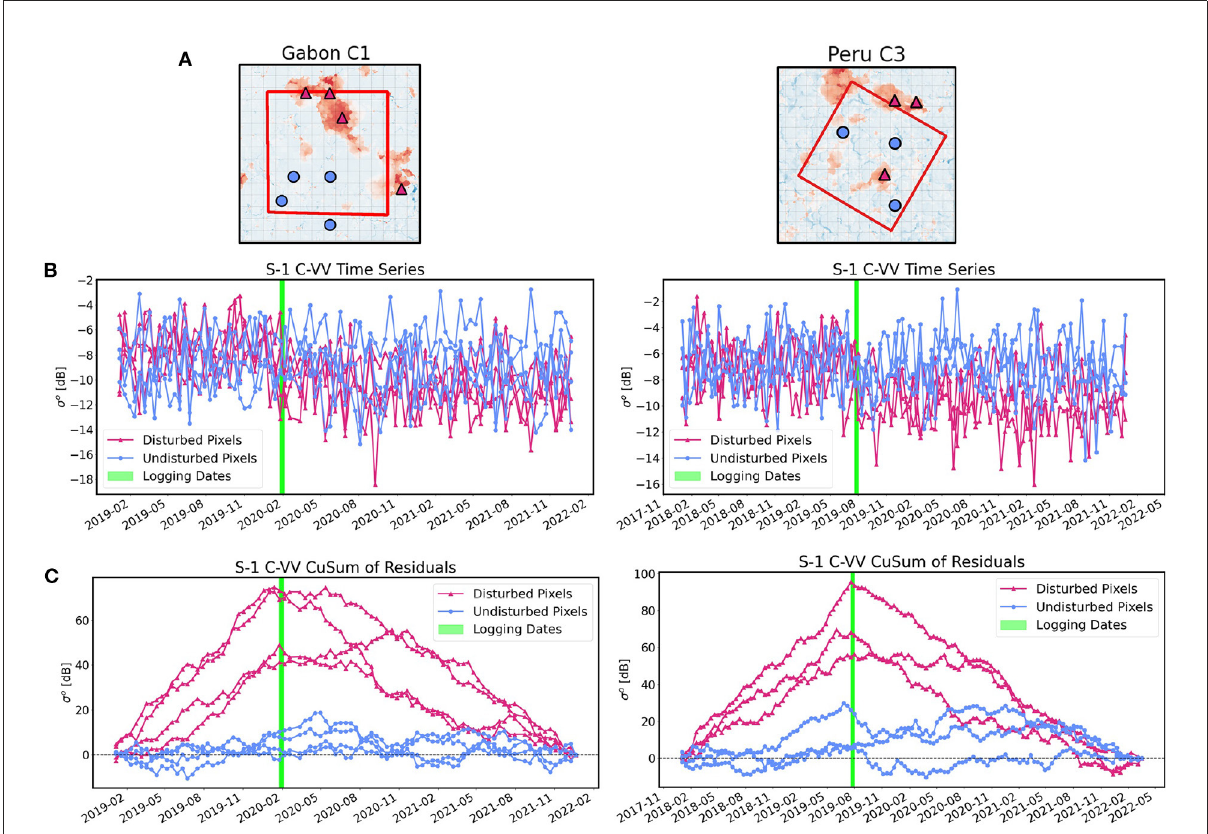
FIGURE3 Comparison of disturbed and undisturbed pixels for selectively logged plots in (left) Gabon and (right) Peru. (A) Location of the disturbed pixels (purple triangles) and undisturbed pixels (blue circles) on the Canopy Height Change raster from the UAV LiDAR measurements. Disturbance areas on the LiDAR map are indicated in dark red. (B) Time series of Sentinel-1 (S-1) SAR backscatter values for the disturbed and undisturbed pixels. (C) CuSum curves for the disturbed and undisturbed pixels. Pixels where logging activities took place display a bell-shaped curve peaking around the time of logging (green